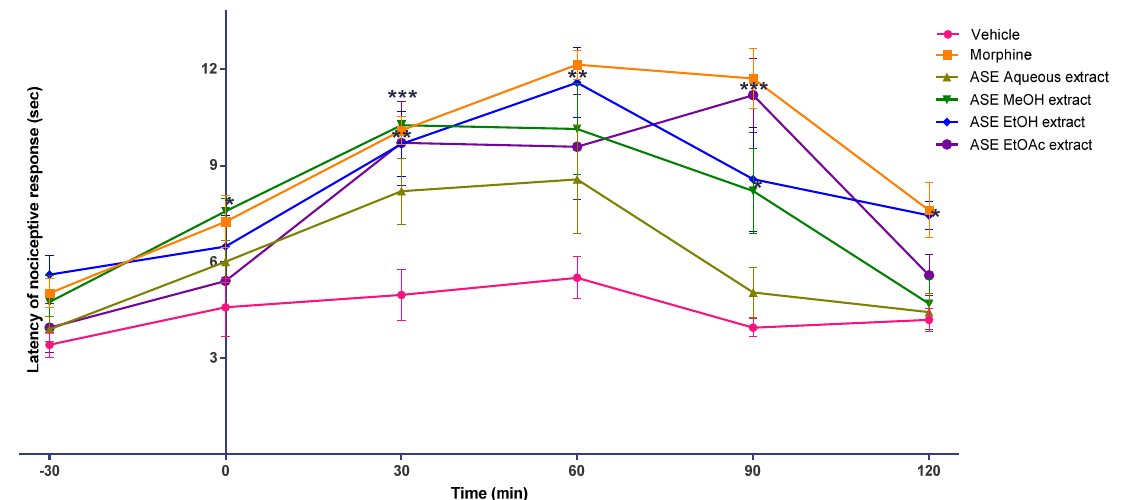
Figure 4. Effects of vehicle, morphine and M. speciosa ASE leaf extracts on Swiss albino mice nociceptive response to tail-flick test. Extracts were administrated orally (morphine injection, s.c.), and nociceptive response was measured at 30 min interval over 120 min in mice. Data shown as mean ± SEM ( n = 6). * p < 0.05, ** p < 0.01, *** p < 0.001 compared with vehicle group (one-way ANOVA, followed by Dunnett’s test).